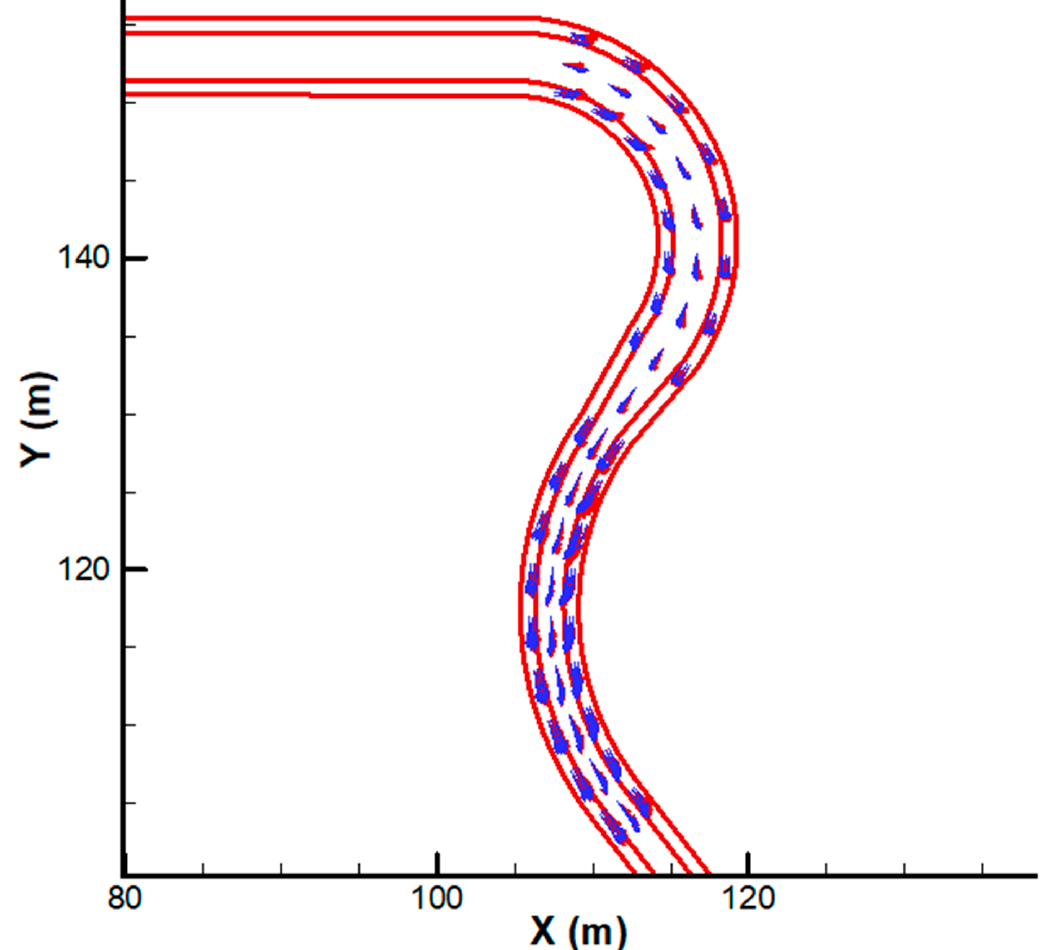
Figure A8. Plan-view comparison of simulated (blue) and measured (red) velocity vectors for the entire region of the physical model.